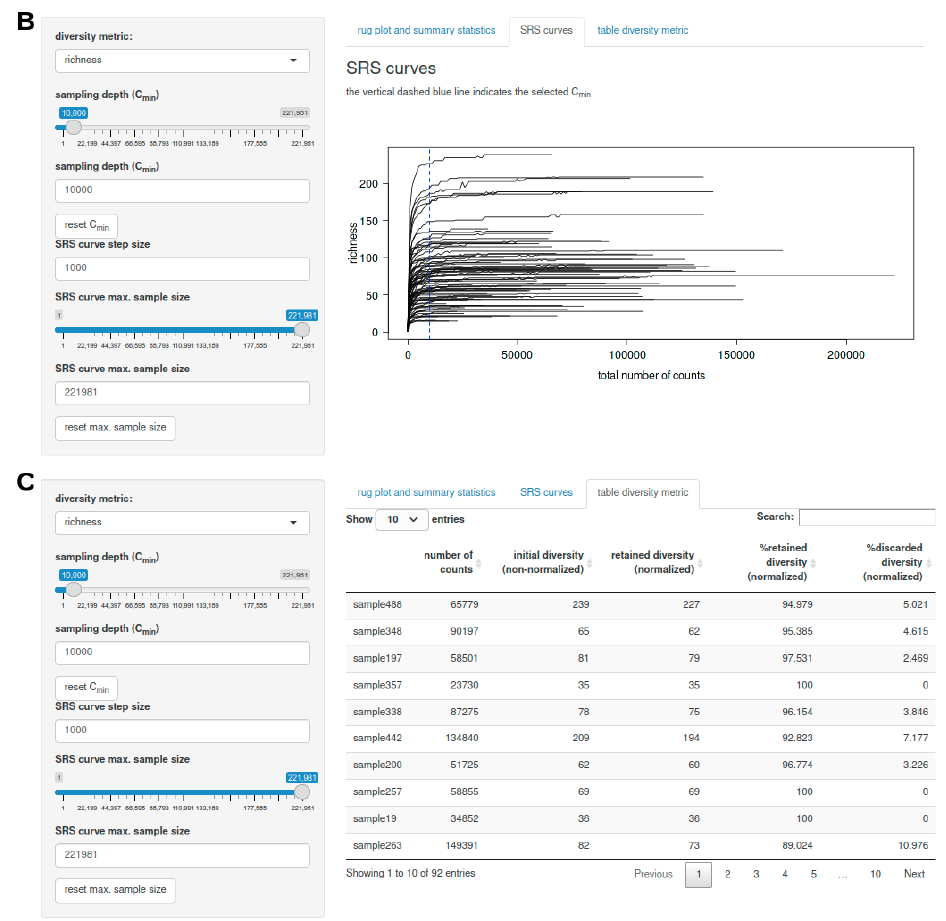
Figure 1. User interface of the Shiny app for SRS ( SRS.shiny.app -function of the ‘SRS’ R package version 0.2.2). ( A ) Rug plot showing the distribution of the number of counts per sample, discarded samples, and summary statistics; ( B ) plot showing SRS curves; ( C ) interactive table with sample names, the number of counts per sample, and summary statistics for the diversity metric.